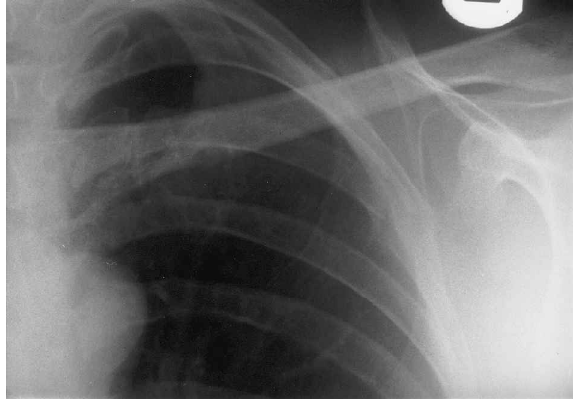
Fig. 2. Radiograph of ribs demonstrating destructive osteolytic lesions affecting ribs 3 and